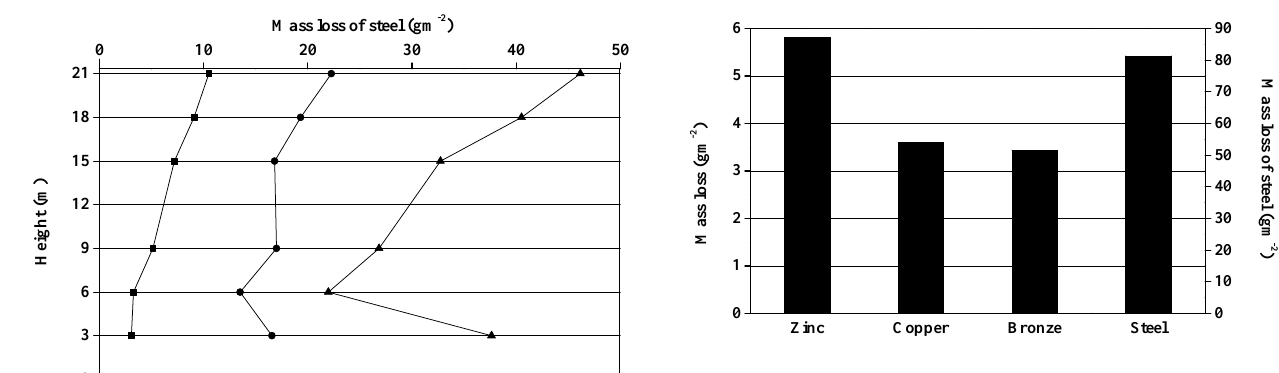
Fig. 6. Mass loss of the specimens exposed for one year on the main rack (unsheltered).